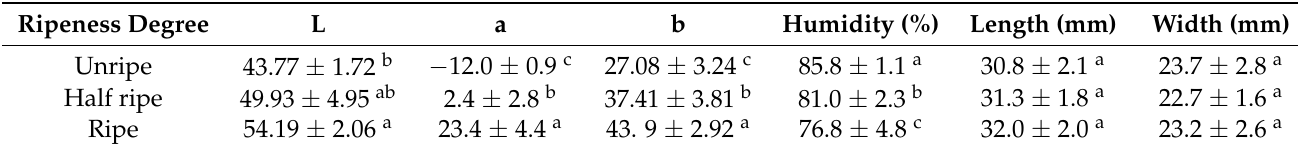
Table A2. Parameters measured to ensure a proper ripeness classification of the habanero peppers.